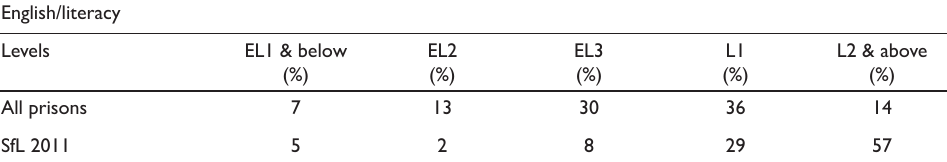
Table 2: Prisoners’literacylevelscomparedwiththe2011SkillsforLife(SfL)survey English/literacy